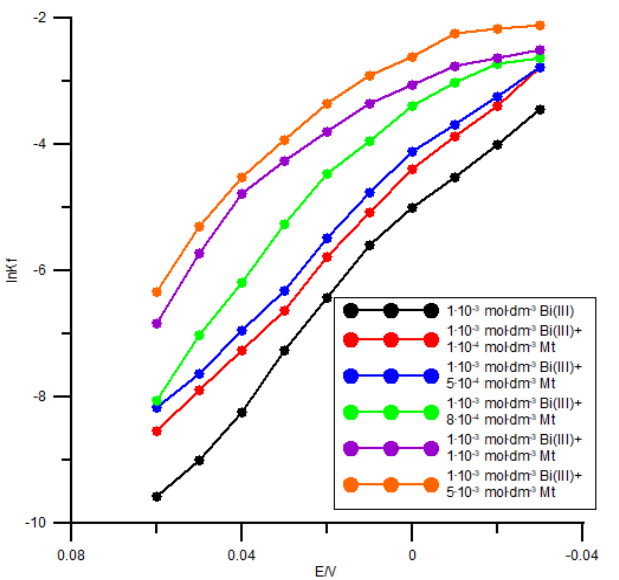
Figure 9. The dependence of the rate constants k f on the electrode potential for the electroreduction of 1 × 10 −3 mol dm −3 Bi(III) in 1 mol dm −3 chlorate(VII) solution in the presence of methionine. The concentration of methionine is given on the plot.